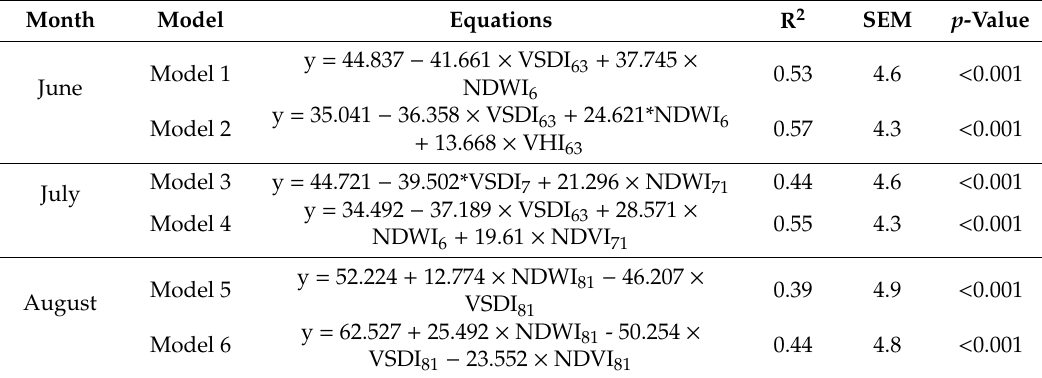
Table 5. Best-fit estimation models for spring wheat yield during the growing period